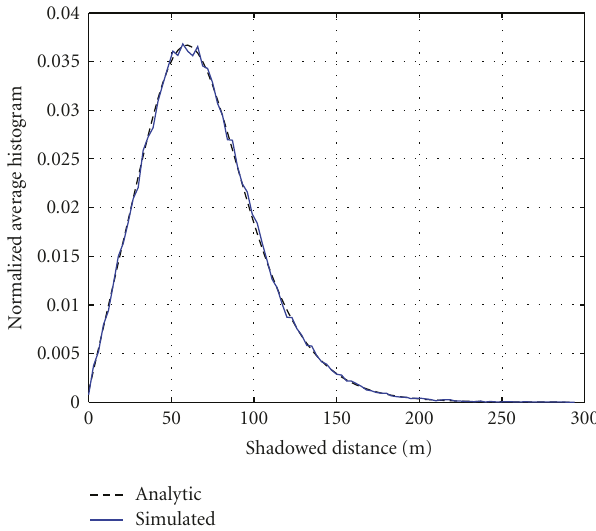
Figure 7: Average histogram of user shadowed